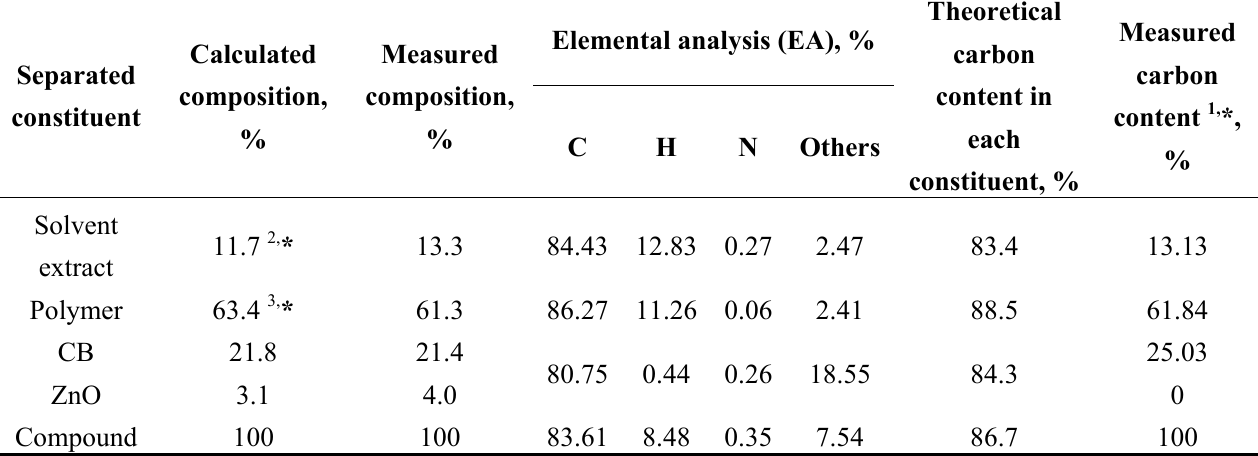
Table 7. Composition, results of elemental analysis, and carbon contents in separated constituents of natural rubber model